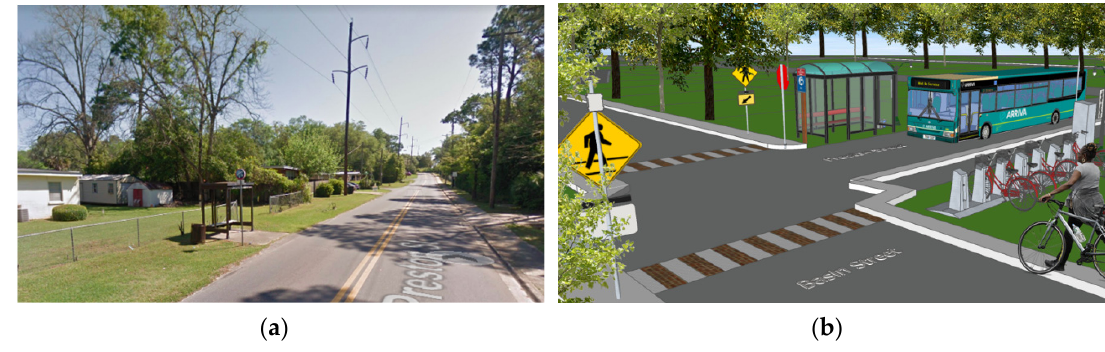
Figure 11. Streetscape improvements: before (a); and after (b).